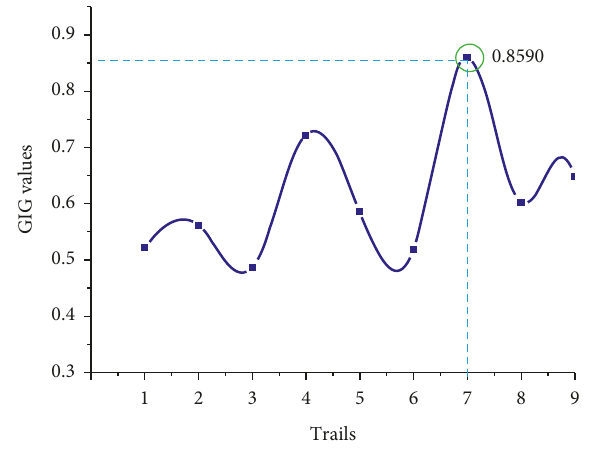
Figure 5: GIG values in different